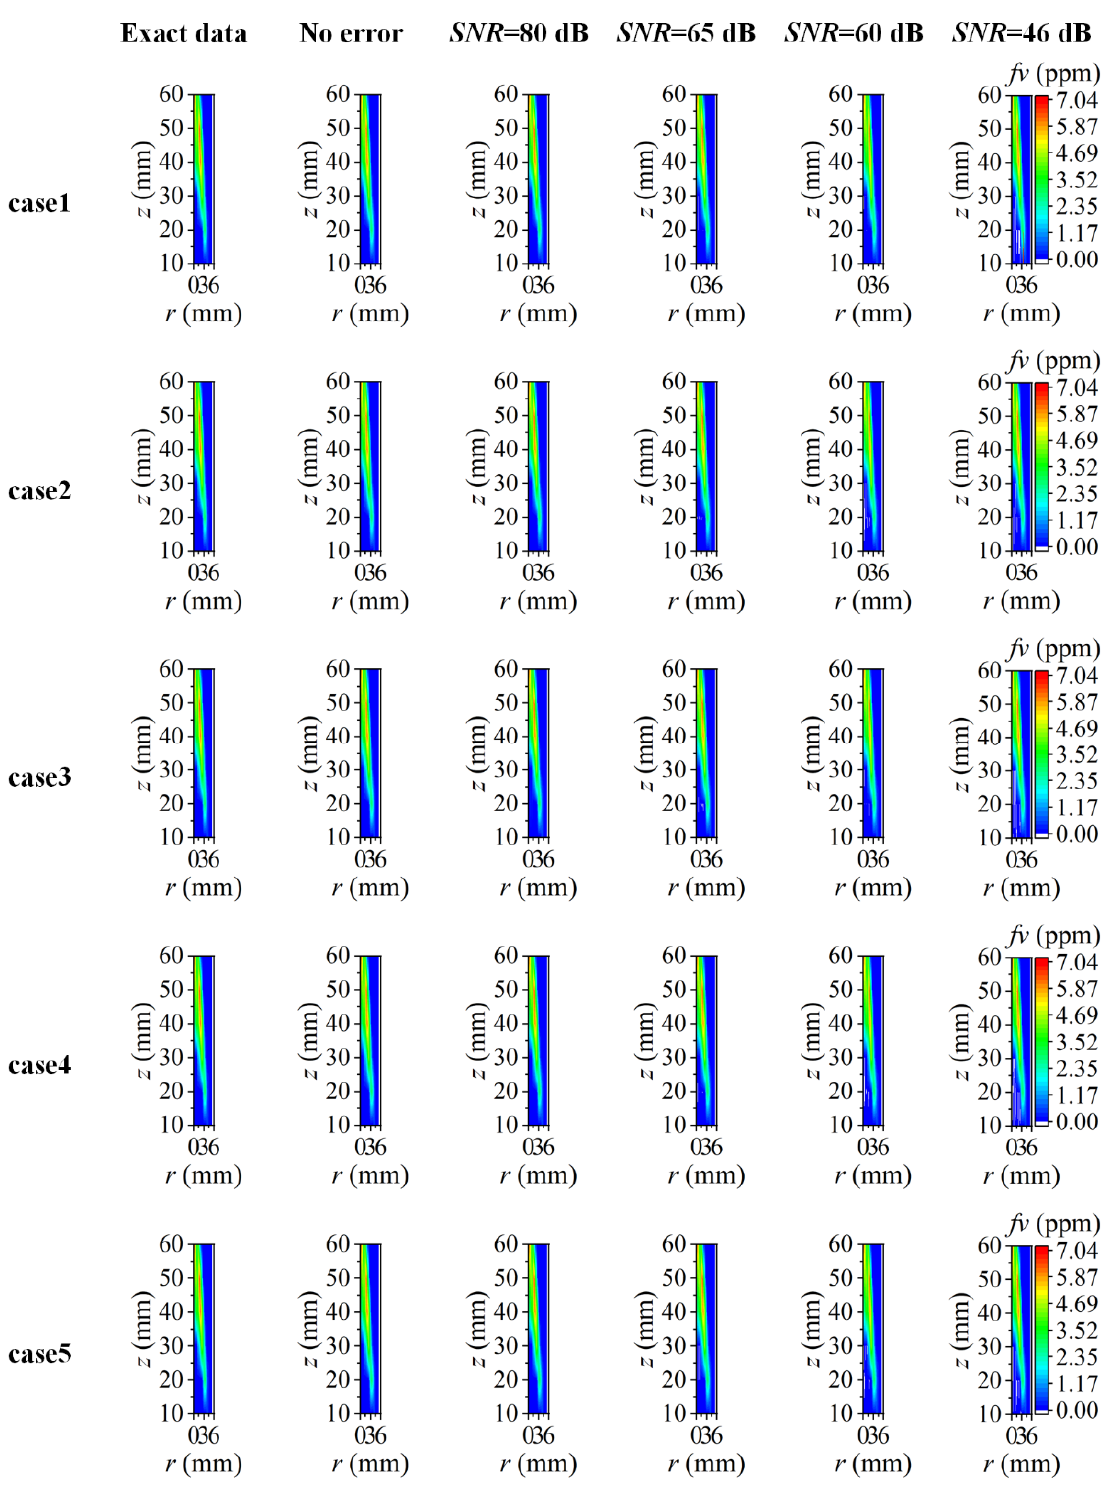
Figure 21. The reconstructed 2D soot volume fraction under different SNR considering different reconstruction boundaries.